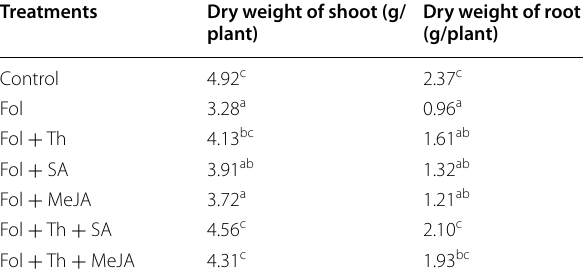
Values followed by the same letters are not significantly different at p